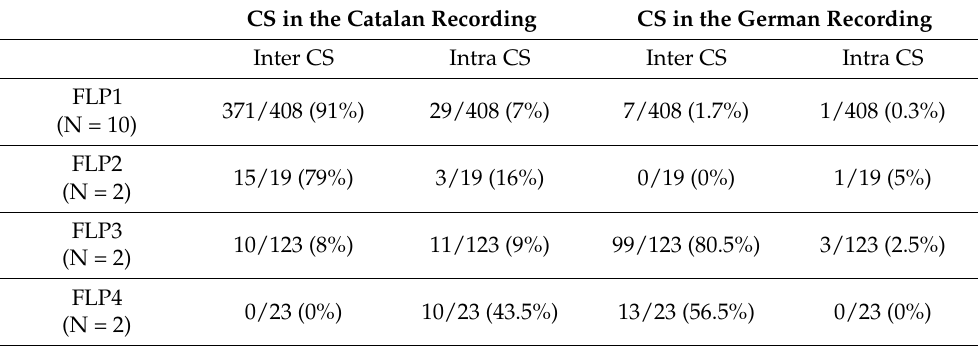
Table 4. Inter- and intrasentential CS and the FLP. CS in the Catalan Recording CS in the German